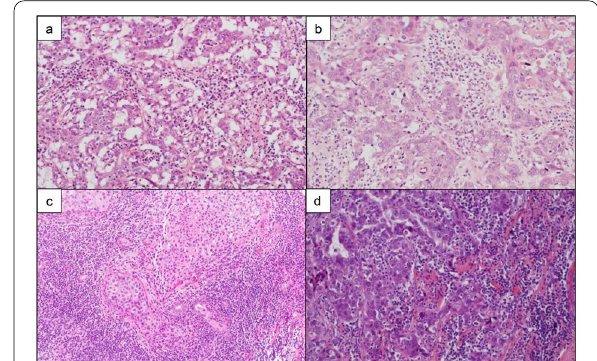
Fig. 3 Microscopic hematoxylin and eosin photograph. a Invasive ductal carcinoma that grows like a follicle on Case 1. b Invasive ductal carcinoma scirrhous type on Case 2. c Microinvasive ductal carcinoma on Case 3. d Invasive ductal carcinoma solid type on Case